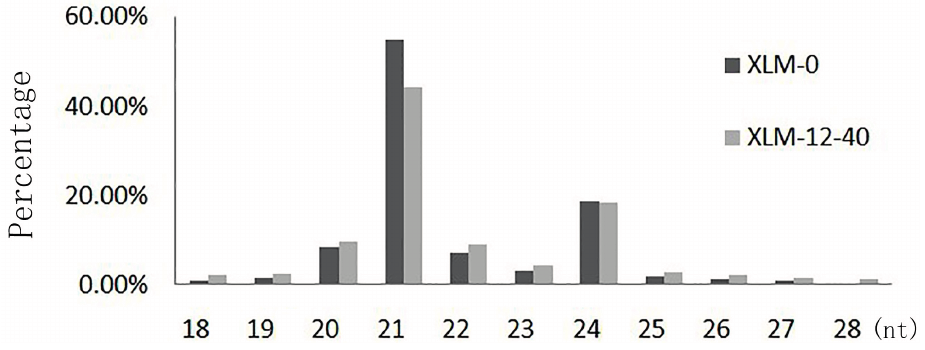
Figure 2. Length distribution of sRNA in two